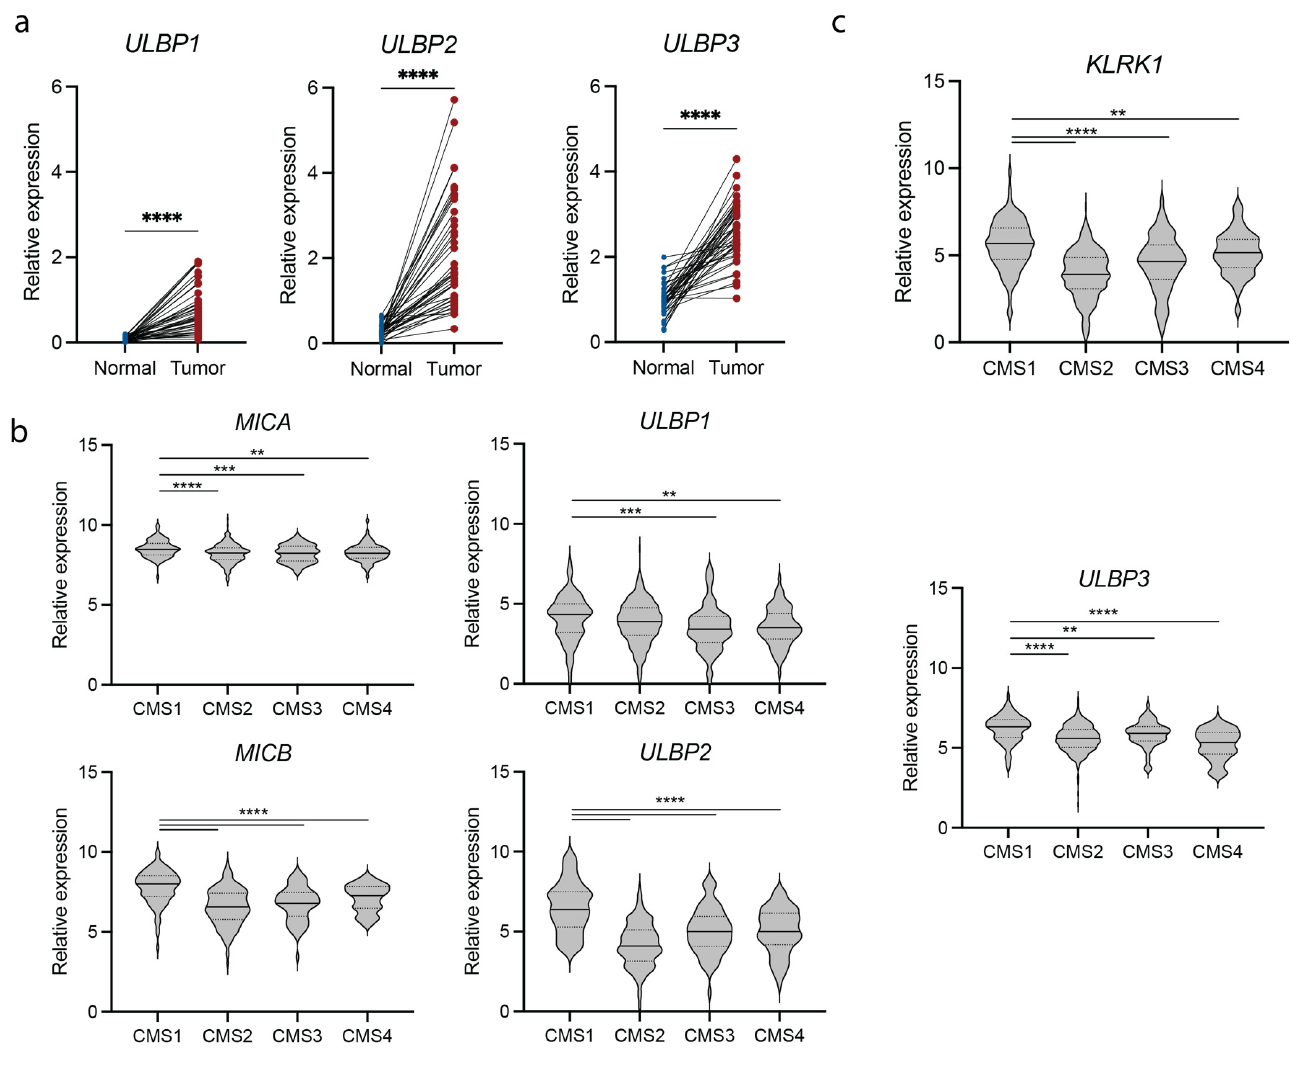
Figure 1. NKG2D and NKG2D ligand expression is increased in CMS1 colorectal cancer patients. ( a ) Relative expression of the NKG2D ligands ULBP1, ULBP2 and ULBP3 in tumor compared to adjacent healthy tissue of COAD patients. ( b ) Relative expression of NKG2D ligands ( MICA, MICB, ULBP1, ULBP2 and ULBP3 ) in di ff erent subtypes of colorectal cancer. ( c ) Relative expression of NKG2D ( KLRK1 ) in di ff erent subtypes of colorectal cancer. COAD = Colon Adenocarcinoma, CMS = consensus molecular subtype. Statistical signi fi cance was determined using paired t -test or Wil- coxon matched-pairs signed rank test ( a ) following Shapiro-Wilk normality test or Wilcoxon Rank Sum ( b , c ). ** p ≤ 0.01, *** p ≤ 0.001, **** p ≤ 0.0001. CRC is a heterogeneous disease, and the response to immunotherapy in CRC patients tumors with high in fi ltration of immune cells are classi fi ed as CMS1 and are typically as-